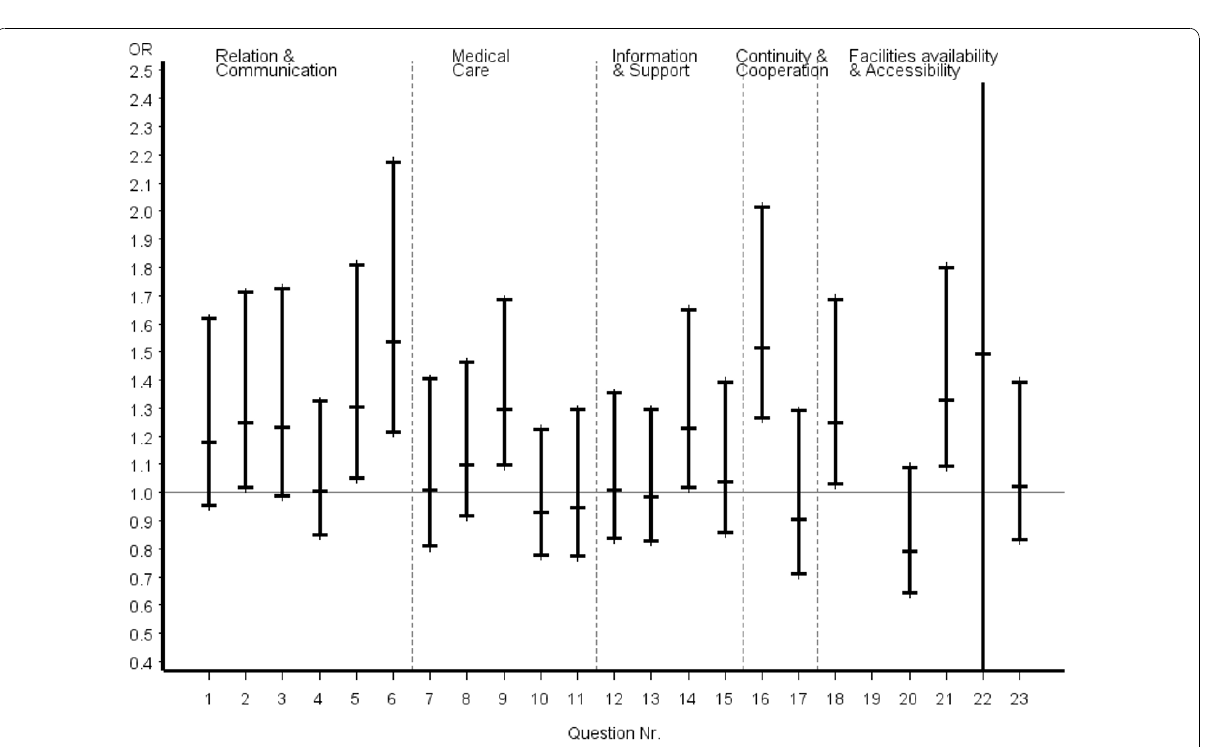
Figure 2 ..Europep questionnaire, odds ratios of most favourable answer option (certified CAM vs. COM) Stratified analysis of patients with severe conditions (patient rated) . Errorbars denote 95% confidence intervals of odds